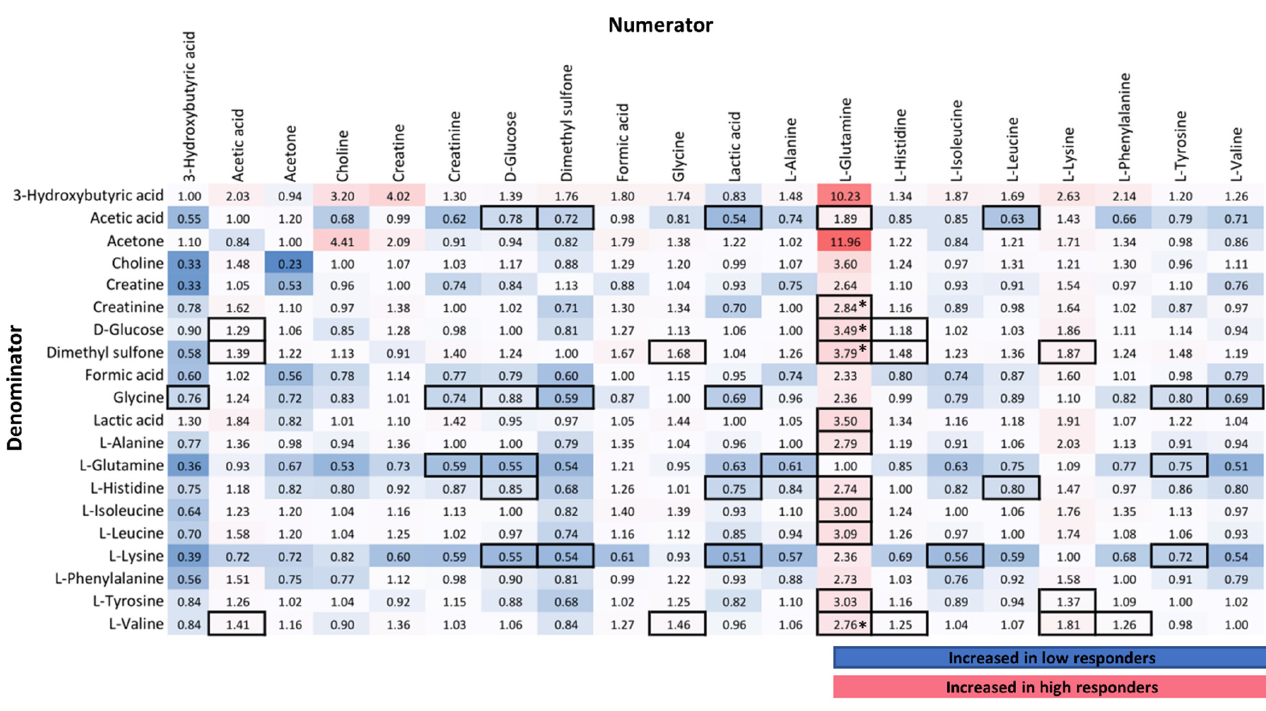
Figure 2. Fold-change of high vs. low responders of metabolic ratios in Day 1. Columns show the numerator and rows the denominator of each ratio. For example, the L -Glutamine/ D -Glucose ratio exhibits a 3.49-fold increase in the high responders compared to the low responders. The changes in the metabolic ratios found statistically significant using t -tests ( p -value < 0.05) are in boxes. Asterisks (*) indicate statistical significance after FDR correction ( p -value < 4.62 × 10 − 4 ). Color coding is based on conditional formatting of fold-change values.